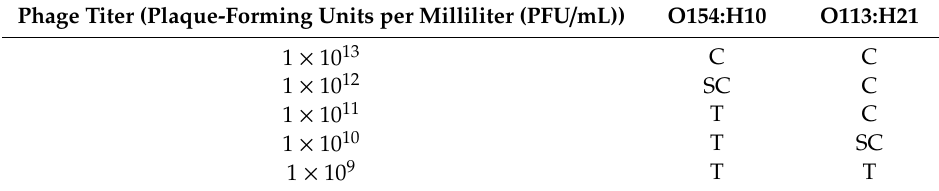
Figure 1. One-step growth curve of phage SA21RB. Table 1. Lytic effect of phage SA21RB on E . coli O154:H10 and E. coli O113:H21.